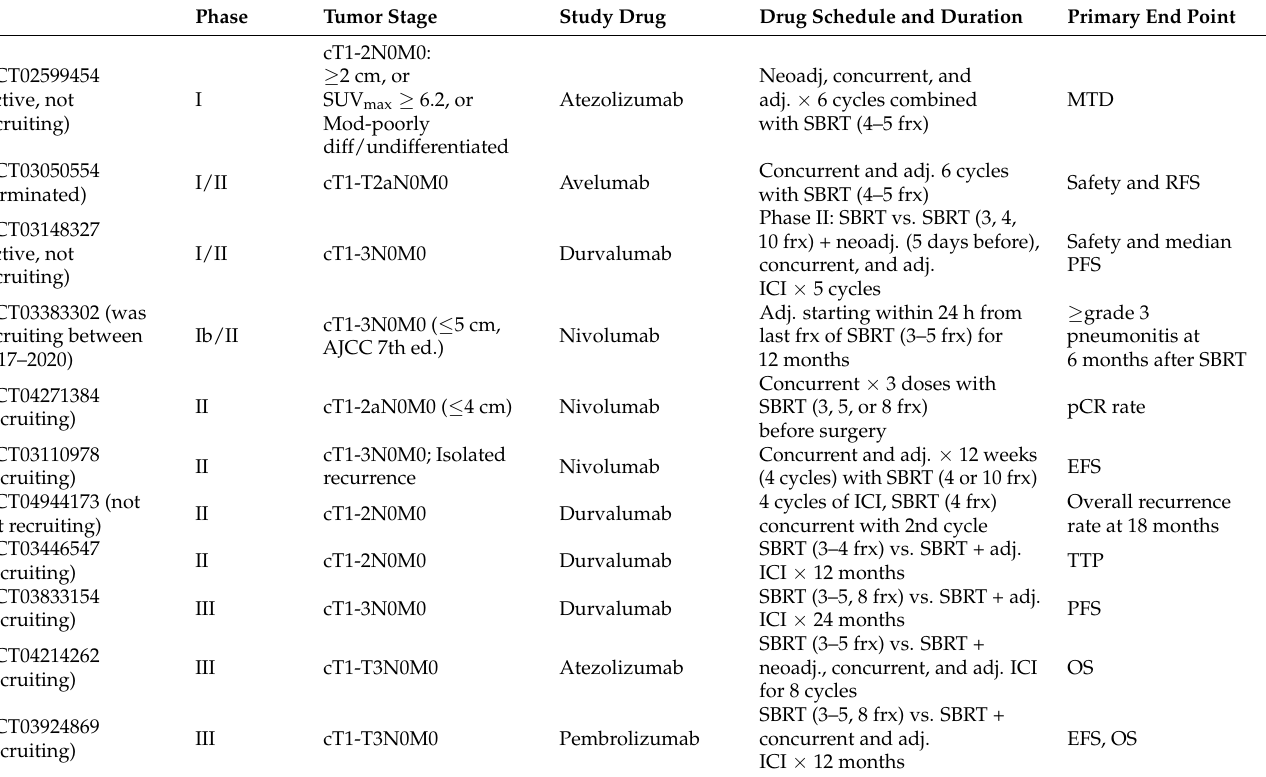
Table 5. Clinical trials investigating SBRT and ICI combinations for N0 ES